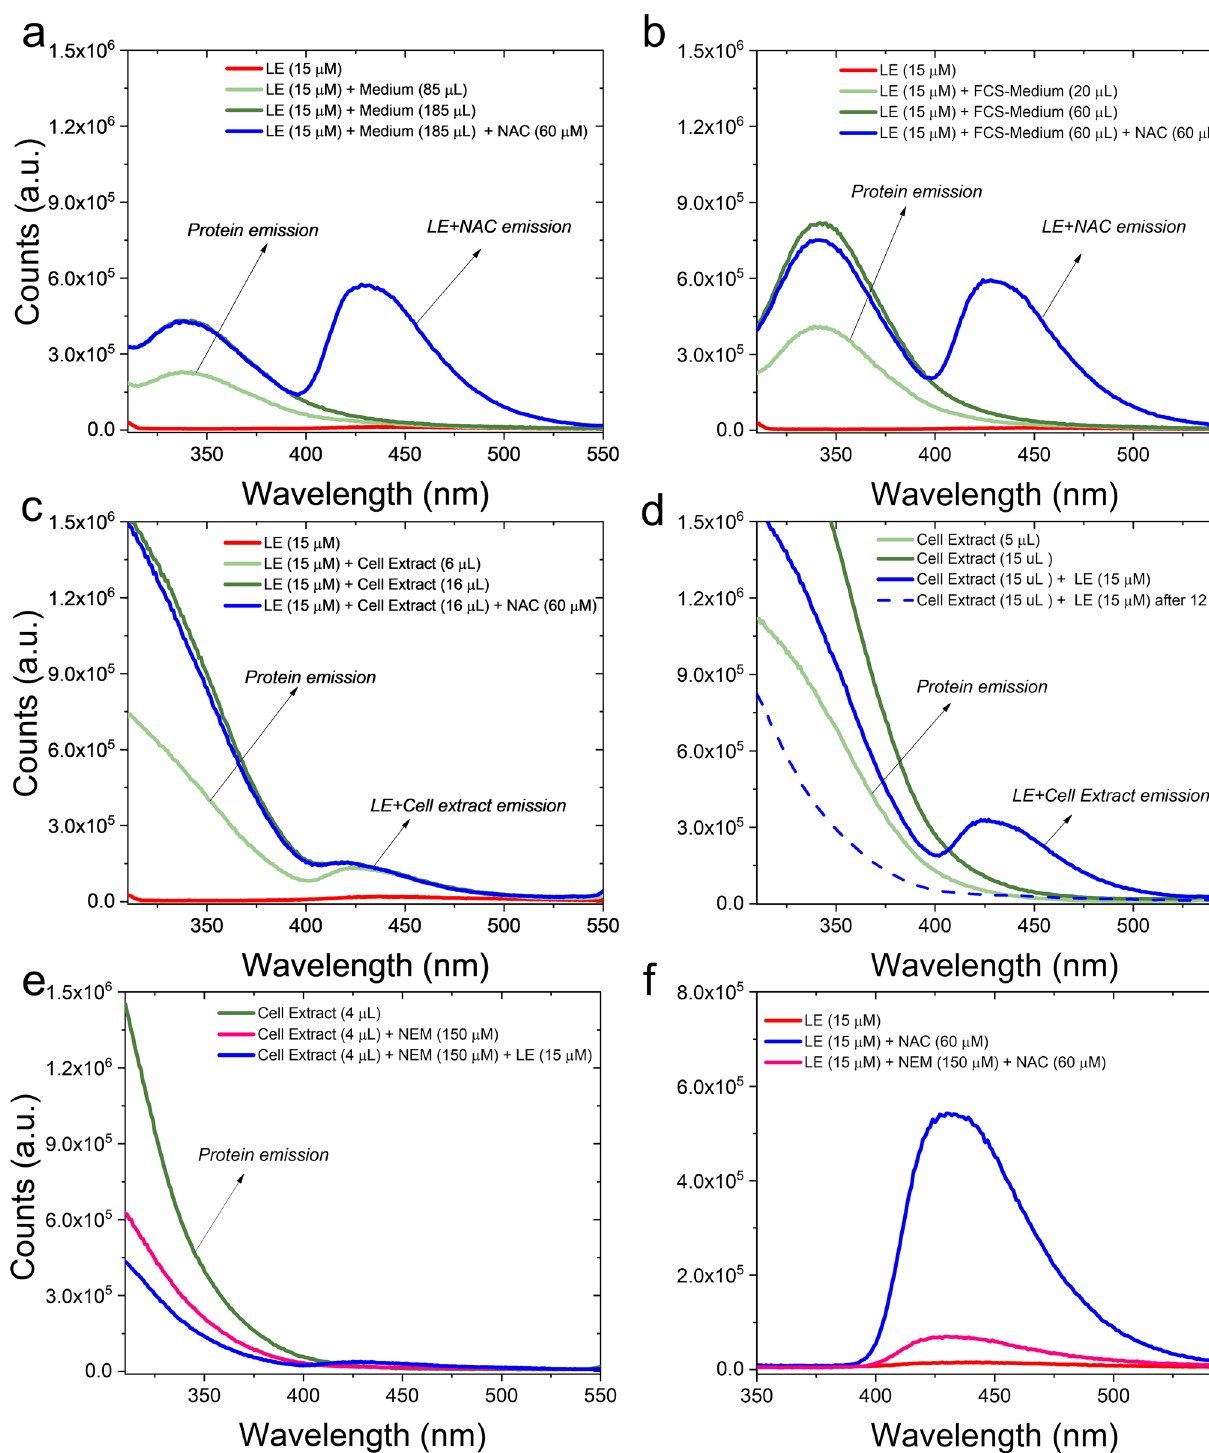
Fig. 6 LE-related fl uorescence in cell culture medium and cell cytosolic extracts. Fluorescence pro fi le of ( a ) LE (red line) in combination with cell culture medium without (green and light-green lines) and with NAC (blue line); b LE (red line) in combination with cell culture medium supplemented with FCS without (green and light-green lines) and with NAC (blue line); c LE (red line) in combination with Hep3B cell extract (protein content: 3.7 μ g/ μ l, diluted in 2 ml) without (green and light-green lines) and with NAC (blue line); d Hep3B cell extract (green and light green lines) in combination with LE (blue solid line), also after 12 h (blue dashed line); e Hep3B cell extract alone (green line), preincubated with NEM (fuchsia line) and after mixing the latter with LE (blue line); f LE (red line) in combination with NAC (blue line) and with NAC previously preincubated with NEM (fuchsia line). λ exc = 280 nm; slit width: 2.5 nm/5 nm; Tris-HCl 50 mM, pH =